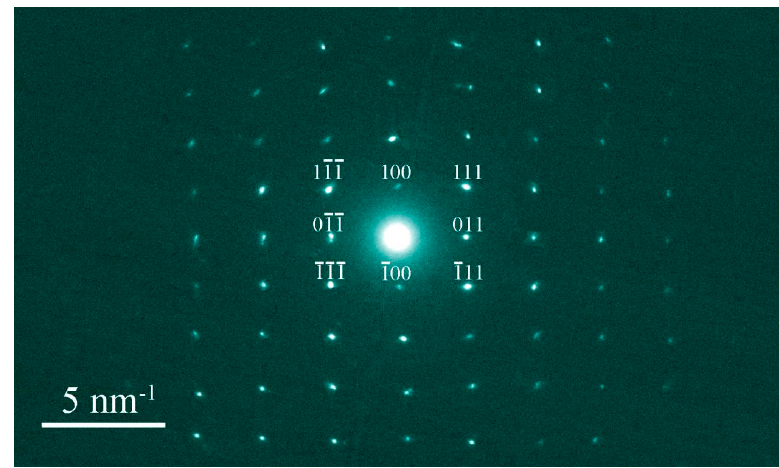
Figure 2. Electron diffraction pattern for ZnWO 4 nanoplates with {0 1 1} facet.